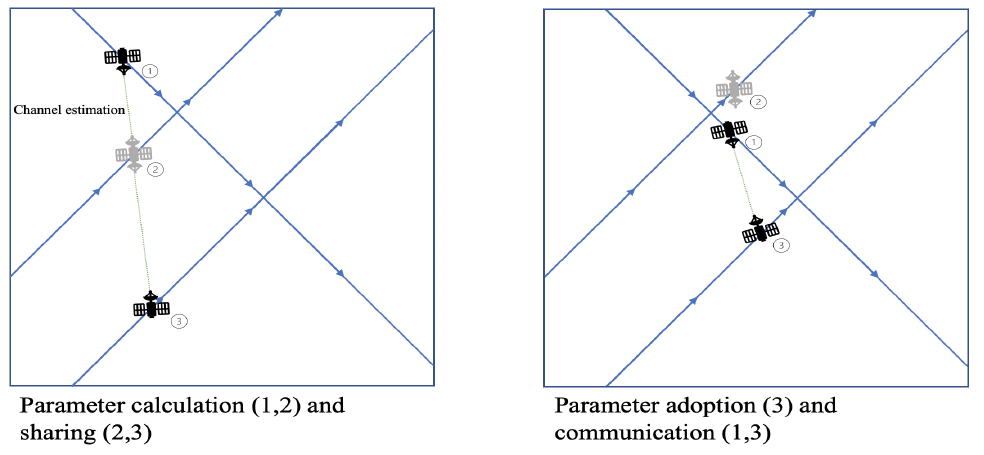
Figure 1. Sharing of learned parameters in a satellite